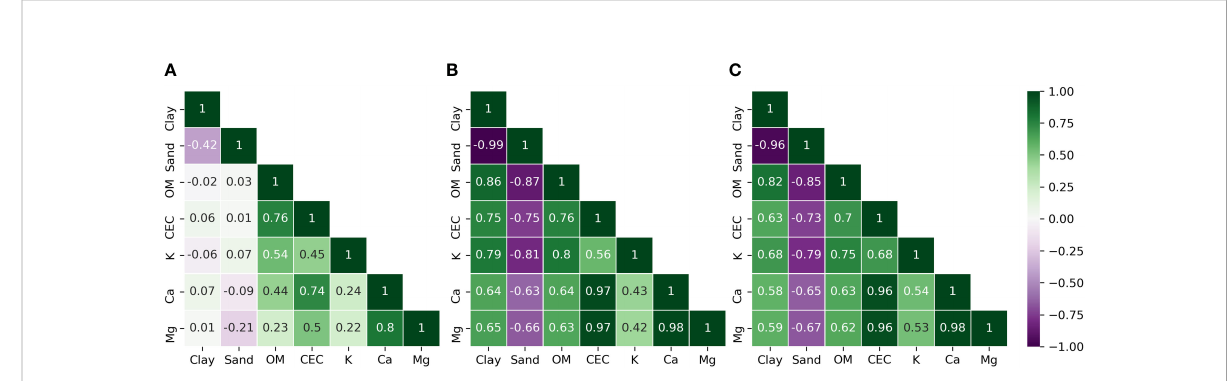
FIGURE 4 Pearson correlation matrix of laboratory analysis from soil samples that composed the three strategies of datasets used in this study. (A) Local dataset; (B) geological dataset; (C) global